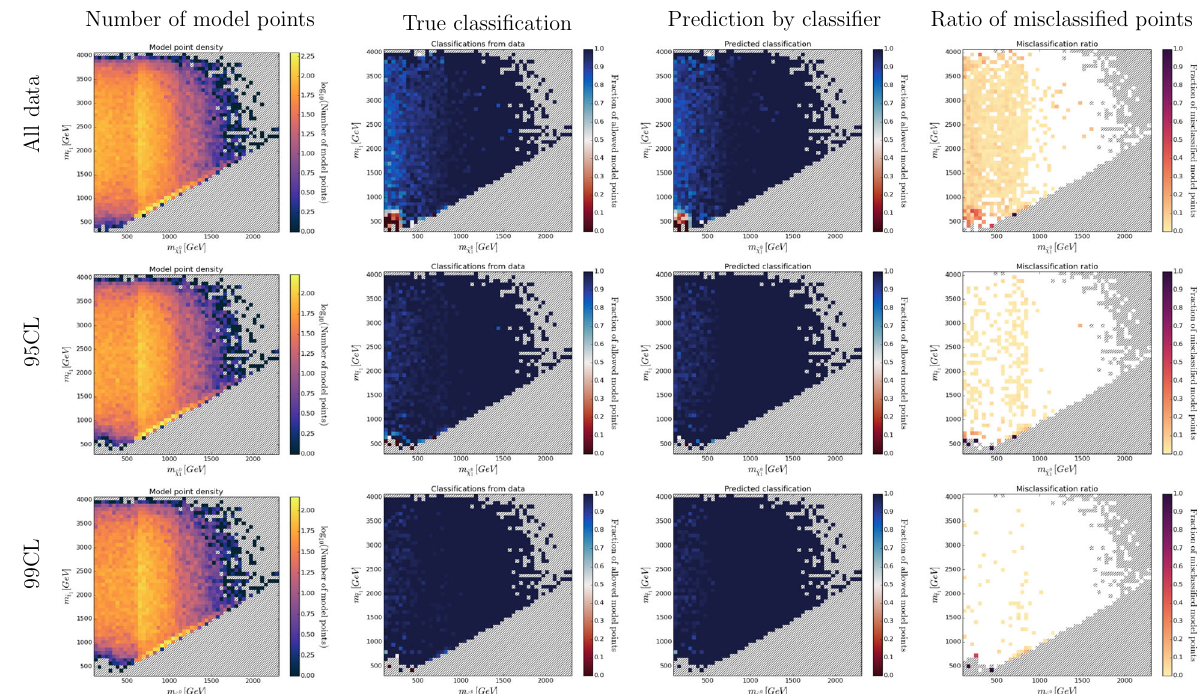
Fig. 11 Color histograms for a projection of the 19-dimensional ( left ). The color in the second and third column indicates the fraction of pMSSM parameter space on the m ˜ t – m ˜ χ 0 plane after imposing the allowed data points. The last column shows the fraction of misclassified 1 1 points. The dashed bins contain no data points constraints on the soft breaking parameters summarized in Table 8